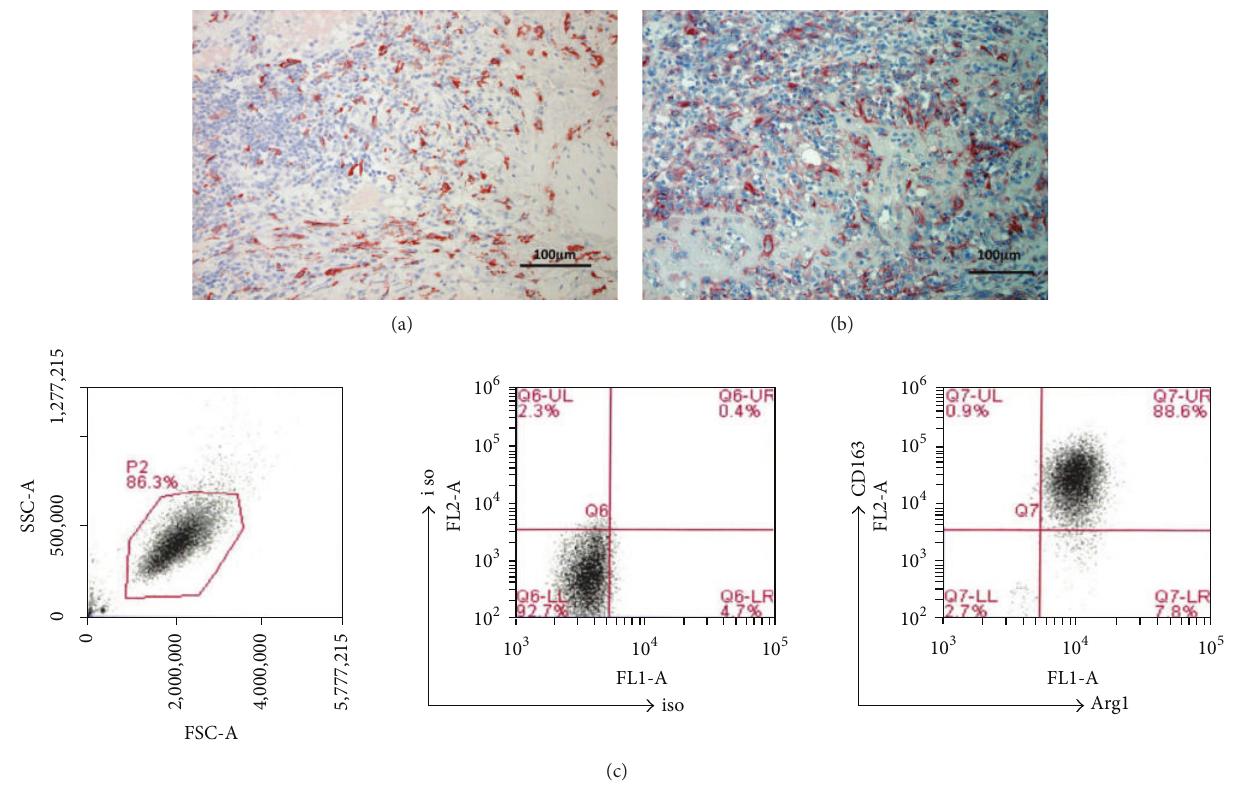
Figure 1: Paraffin-embedded tissue samples from patients with recurrent AS after being treated with DTX monotherapy were deparaffinized and stained as follows: anti-CD163 Ab (a) and anti-MMP9 Ab (b). Sections were developed with liquid permanent red (A) and with 3,3 󸀠 - diaminobenzidinetetrahydrochloride.M2macrophageswereinducedfromPBMCfromhealthydonorsasdescribedinMaterialandMethods section. M2 macrophages induced from PBMC from healthy donors were cultured for 5 days, treated with human IL-4 at day 5, and stimulated with DTX and/or RS. These cells were harvested from the culture and their expression of M2 macrophage-associated molecules (CD163, Arg1) was analyzed by flow